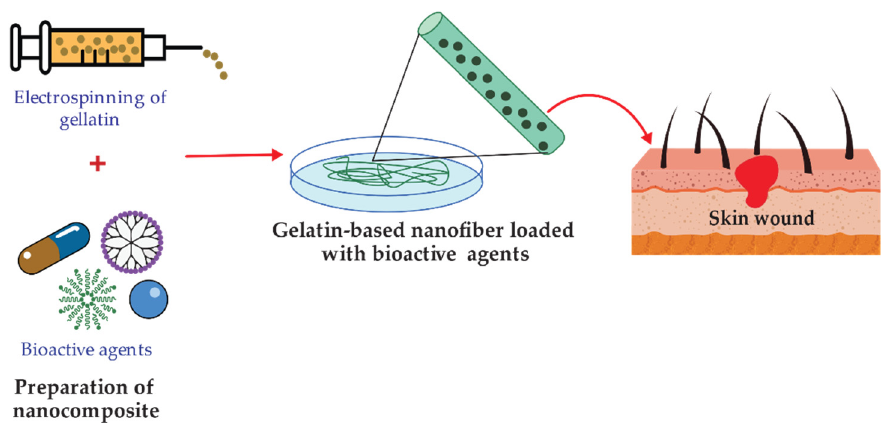
Figure 5. Representation of functionalized gelatin-based nanofibers preparation for wound treat- ment